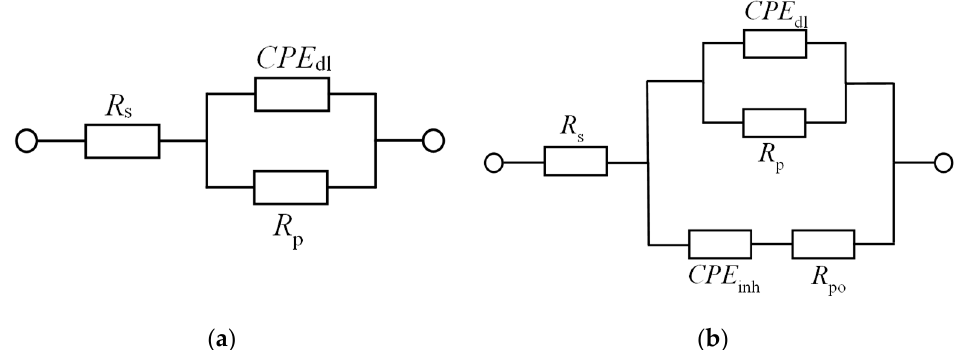
Figure 4. ( a ) Simple equivalent circuit ( b ) Equivalent circuit for the inhibited solution (Adapted from [24]).